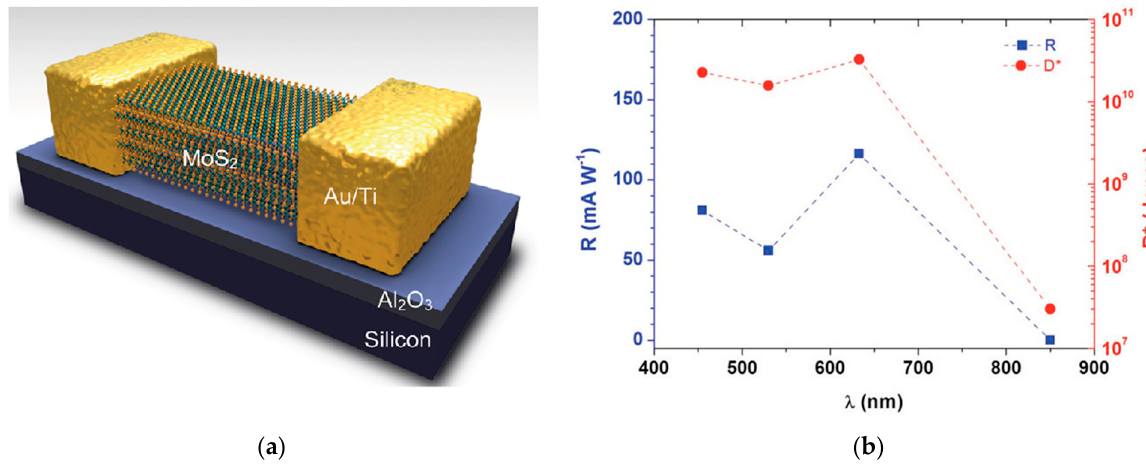
Figure 8. ( a ) Scheme of a phototransistor based on MoS 2 . ( b ) Responsivity and detectivity of the phototransistor over the visible-NIR spectral range. Reprinted with permission from ref. [23]. © 2012, John Wiley and Sons.